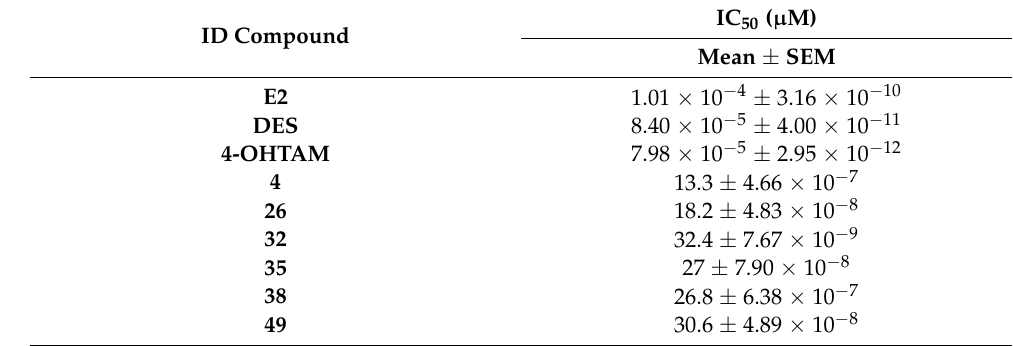
Table 3. Binding affinities of 5-hydroxy-2 H -pyrrol-2-one compounds to rhER α . The binding of competitors (compounds 4 , 26 , 32 , 35 , 38 , 49 or controls: E2, DES or 4-OHTAM) to rhER α was evaluated in 10-point titration competition curves (0.1 nM–20 µ M) by using the LanthaScreen TR- FRET competitive binding assay as described in the Material and Methods. Non-linear regression analysis was performed in GraphPad Prism 8.4.3 to calculate their IC 50 values. Data are expressed as mean ± SEM from two independent assays where each concentration was tested in